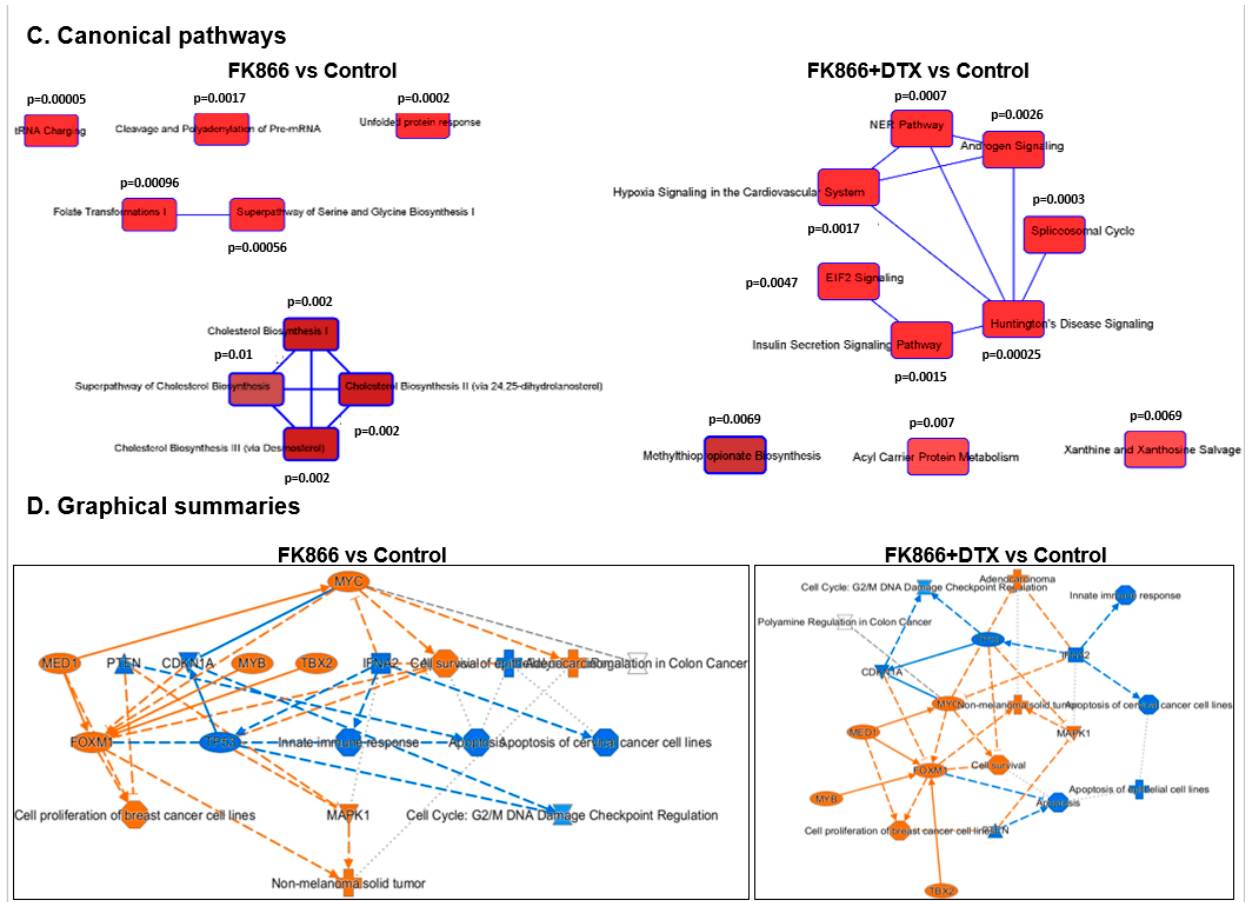
Figure 8. Differential gene expression profiling analysis results. ( A ) Heatmaps representing top dif- ferentially expressed genes (DEGs) following DTX, FK866 single-agent, or DTX + FK866 combination treatments in human mCRPC cell lines ( n = 3), 24 h following drug exposure. (I) FK866 single-agent treatment. (II) DTX + FK866 combination treatment. Log 2 ratios are depicted in a color scale where red represents upregulation and green represents downregulation. Columns represent cell lines and rows represent genes. Prior to hierarchical clustering, gene expression values were filtered (samples with max TPM < 1 were removed) and z-score normalized. ( B ) Venn diagrams represent- ing unique and common DEGs ( p < 0.05) between DTX, FK866, and DTX + FK866 treatments among: I. All mCRPC lines; II. DU145 vs. DUTXR lines in all cell lines. Ingenuity pathway analysis: IPA analysis was performed based on the top DEGs following FK866 single-agent of FK866 + DTX com- bination treatments. ( C ) Top canonical pathways. ( D ) Graphical Summaries.